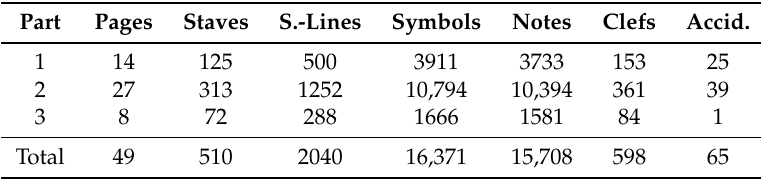
Table 1. Overview of the data set statistics. The data set is split manually into three groups that share similarities in layout or